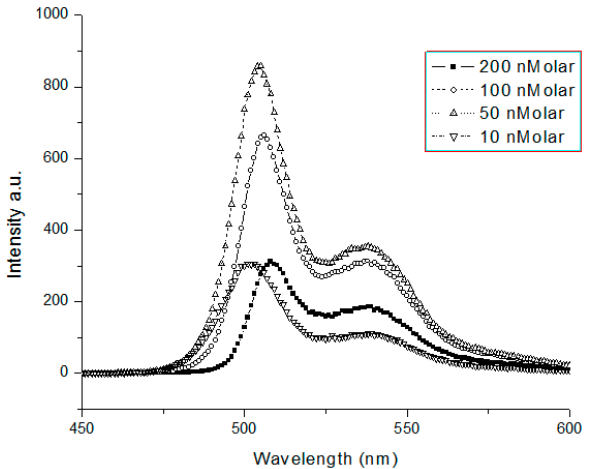
Figure 3. Fluorescence spectra of GP in toluene for concentration ranging from 10 nanomolar to 200 nanomolar.